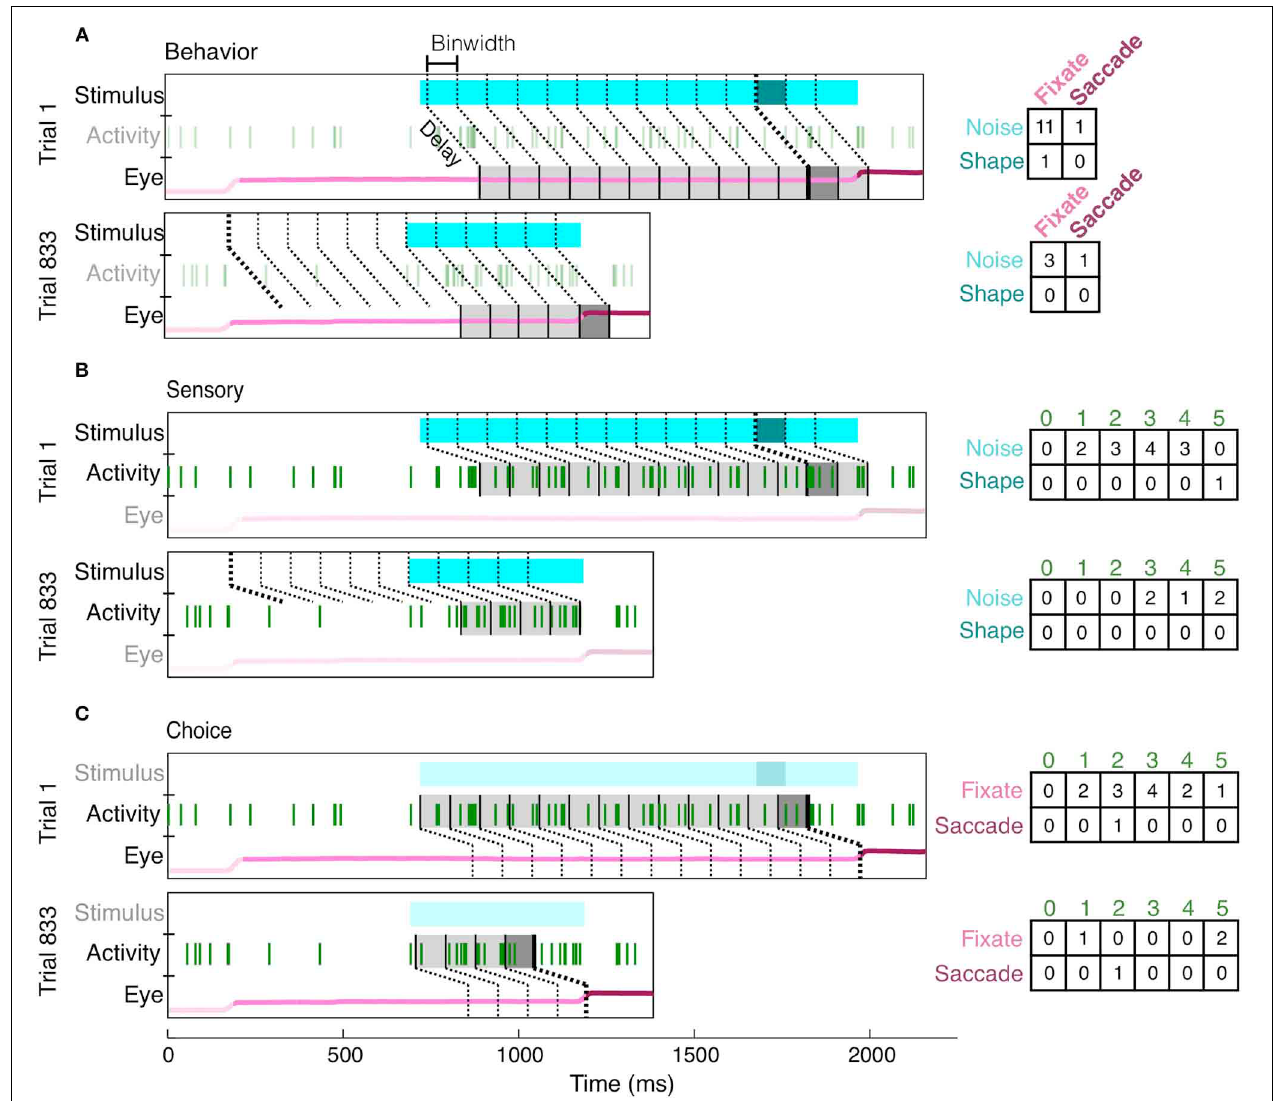
FIGURE 4 | Creation of contingency tables for behavior, sensory, and choice MI at a single delay (shown: 150ms) and resolution (shown: 100ms). For each type of MI, the same two example trials (Trial 1: correct, Trial 833: false alarm) are parsed differently, according to the two appropriate variables of interest (the third irrelevant variable has been dimmed in each subfigure). For behavior MI (A) , the two variables of interest are the stimulus (noise, light blue; shape, dark blue) and eye position (fixate, light pink; saccade, dark pink). Gray bins indicate how the eye position has been parceled according to the delay from the stimulus and the binwidth. The darkness of the bin (light or dark gray) indicates whether the stimulus at this delay was a shape or noise and therefore indicates which row of the contingency table (right) should be updated. Whether the animal was fixating or made a saccade within each bin determines which column is updated. The